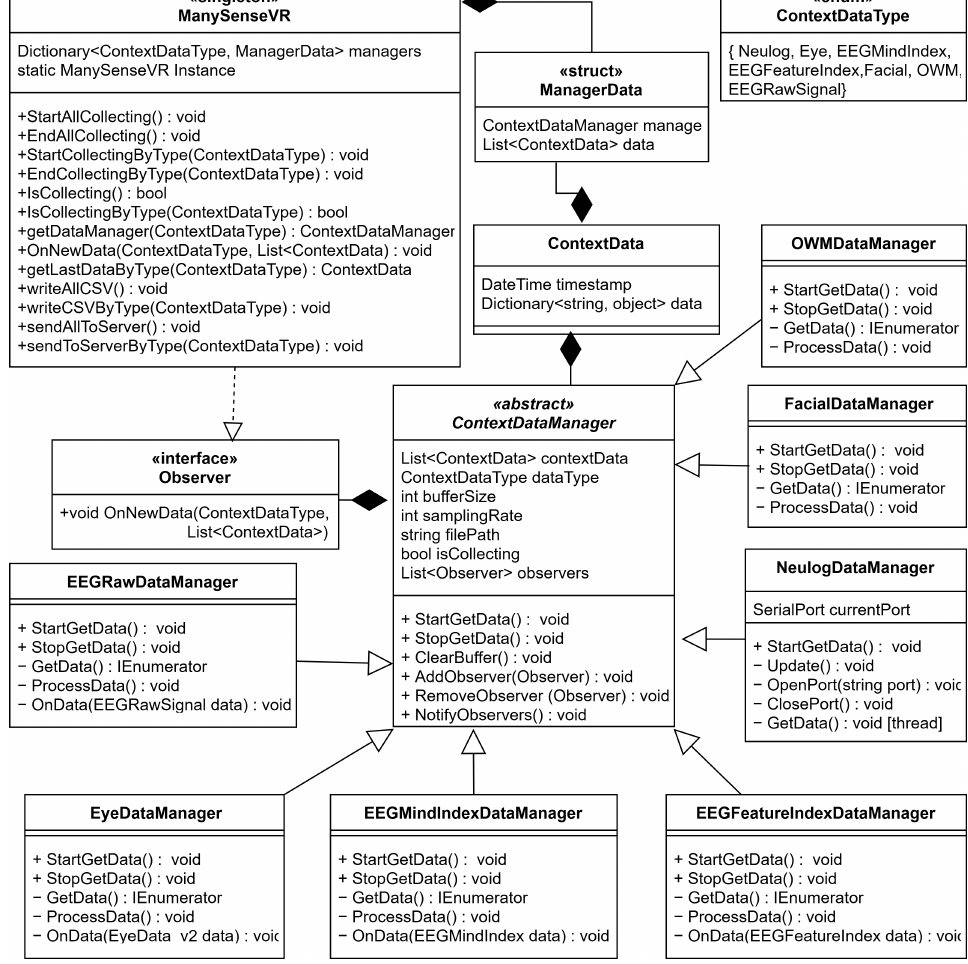
Figure 1. Architecture of ManySense